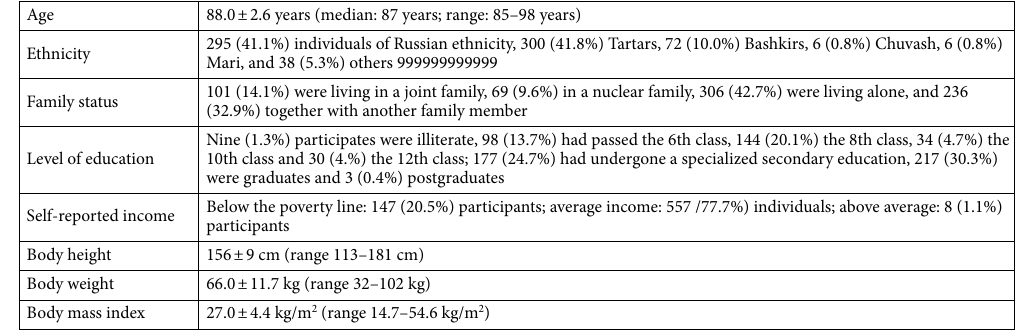
Table 2. Demographic parameters of the study